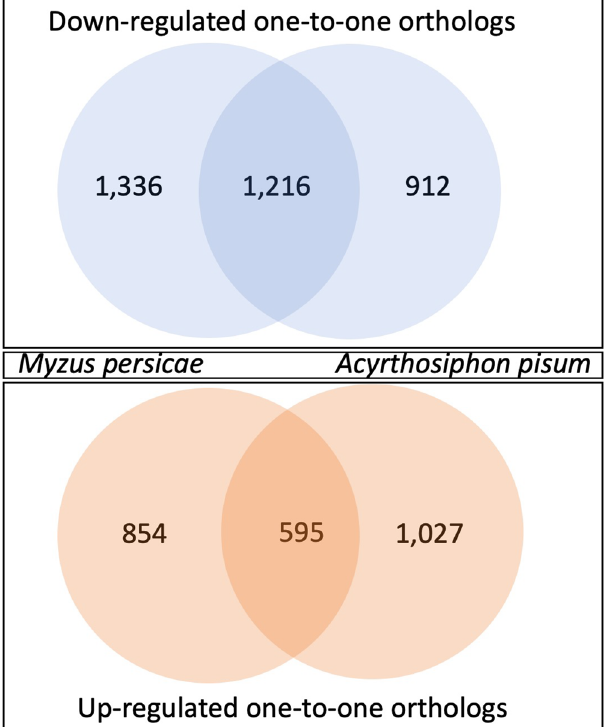
Figure 2. Overview of one-to-one orthologs that have significant differential gene expression in M. persicae and A. pisum for bacteriocytes compared to body tissues, where significance of up- or down-regulation between tissue types is determined for genes with an FDR corrected p-value ≤ 0.05 and fold change (FC) ≥ 1.5 (i.e. LogFC ≥ 0.5849). The shared portion of Venn diagrams indicate that the one-to one ortholog was significantly down-regulated (top panel) or up-regulated (bottom panel) in both aphid species. Un-shared portions of Venn diagrams indicate that the ortholog was only down-regulated (top panel) or up-regulated (bottom panel) in one of the aphid species (left side M. persicae ; right side A. pisum